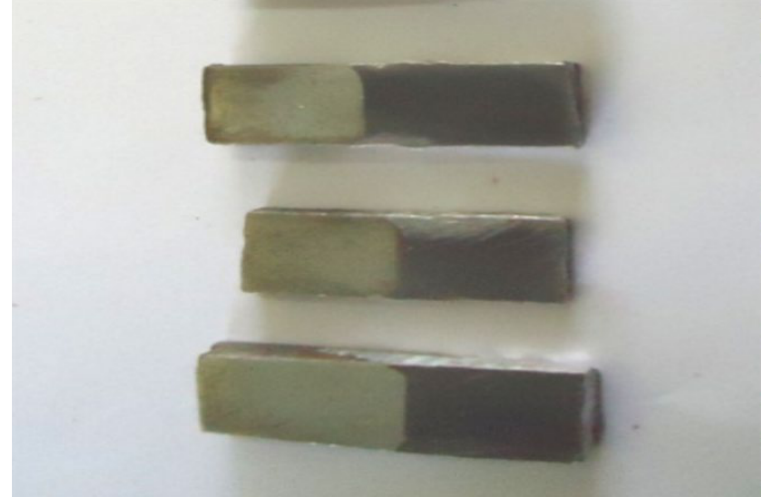
Figure 5. Prepared microstructural research specimens.